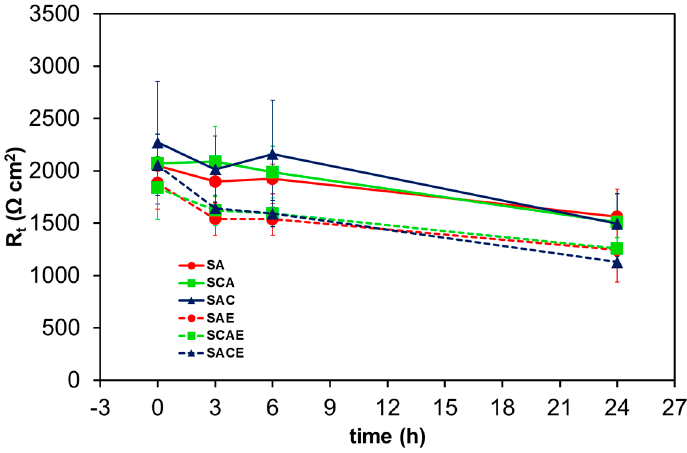
Figure 7. Average charge transfer resistance ( R t ) of the different AA6012 samples in aerated solution as a function of exposure time.